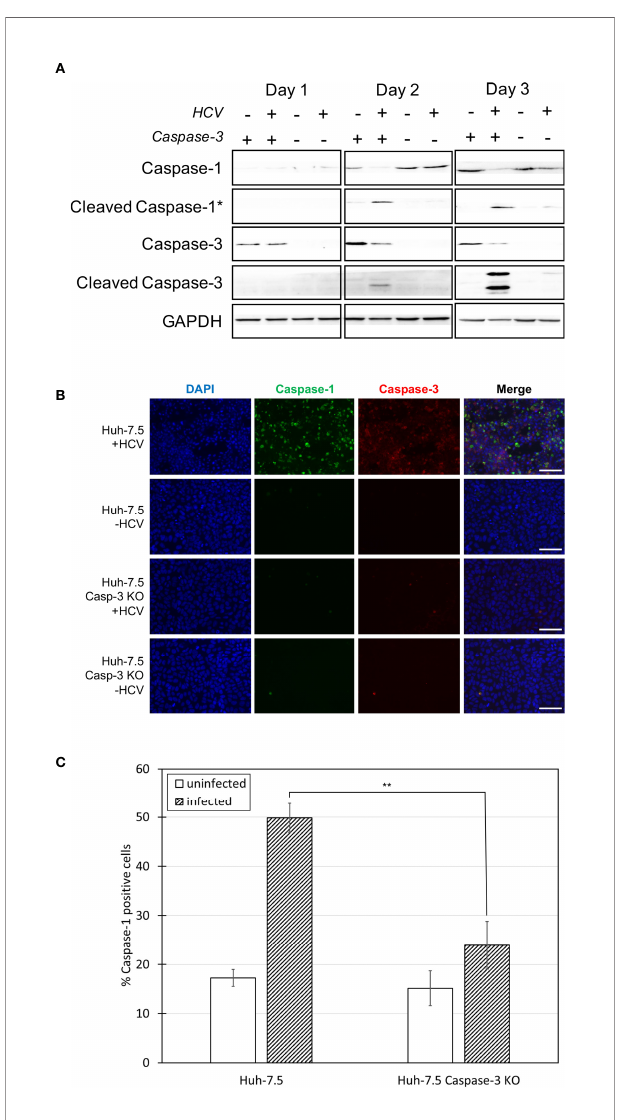
FIGURE 4 | Comparison of caspase levels when apoptosis is inhibited. Huh- 7.5 cells or Huh-7.5 caspase-3 KO cells were infected with HCV at MOI= 1 or left uninfected. (A) At 1, 2, and 3 days p.i., cellsand culture fl uids were harvested for Western Blot analysis. Membranes were probed for pro-caspase-1, cleaved- caspase-1, pro-caspase-3, cleaved-caspase-3, and GAPDH. * indicates samplesfrom cell culture fl uids rather than cell lysates. (B) At 3 days p.i., cells were stained usinga probespeci fi c for cleaved caspase-1 (green), then fi xed usingacetone. Cells were subsequently stained using a speci fi c antibody for cleaved caspase-3 (red). Nuclei were stained with DAPI (blue) and analysis was by fl uorescence microscopy. Scalebar, 100 m m (C) At day 4 p.i., cells were stained for cleaved caspase-1 using a speci fi c probeand fi xed using fi xative from the caspase-1 probekit. Cells were run on a CytoFLEX fl ow cytometer and data were analyzed usingKaluza analysis software and presented as the percent of total cells positive for caspase-1. Data from caspase-3 KO cells are compared here to data from wild-type cells found in Figure 1D . **p < 0.005. (A – C) Data are representative of three independent